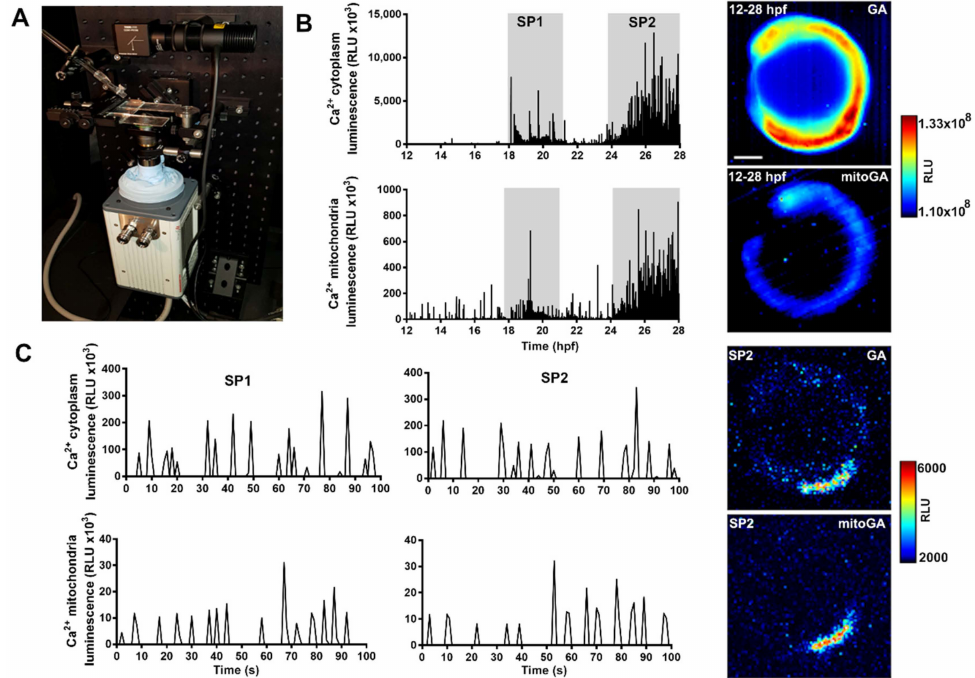
Figure 3. Continuous luminescence imaging of spontaneous Ca 2 + transients in the trunk of zebrafish from 12 to 28 hpf. ( A ) Home-made low light microscope with EMCCD camera. ( B ) Representative experiments showing two periods of increased Ca 2 + signaling, SP1 and SP2, in the cytoplasm and in mitochondria. Note the di ff erent luminescence scales. The images next to the graphs show the accumulated luminescence from 12 to 28 hpf. ( C ) Bioluminescence traces (100 s) corresponding to SP1 and SP2 in the cytoplasm (top graphs) and mitochondria (bottom graphs). The images on the right show one Ca 2 + spike in the cytoplasm (top) and mitochondria (bottom) during the SP2 period. Images were acquired at 1 Hz. The scale bar represents 200 µ m. The color scale indicates